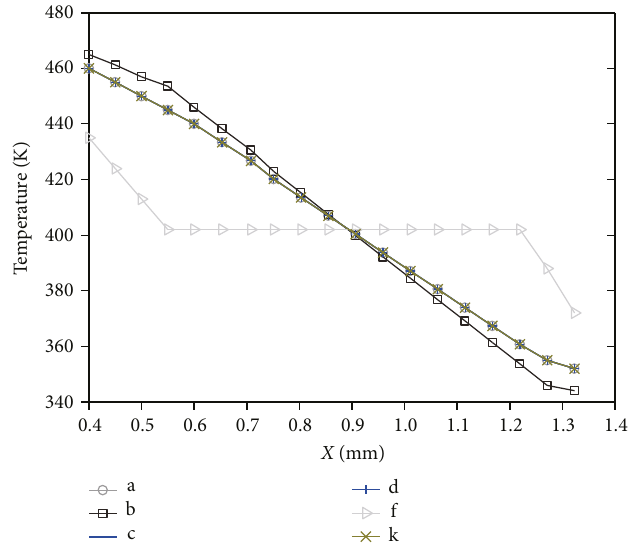
Figure 5: Attenuation curve of temperature wave on the central axis of gas slug under di ff erent working conditions (the two vertical dashed lines whose location is 0.6mm and 1.3mm, resp., indicate the phase interface